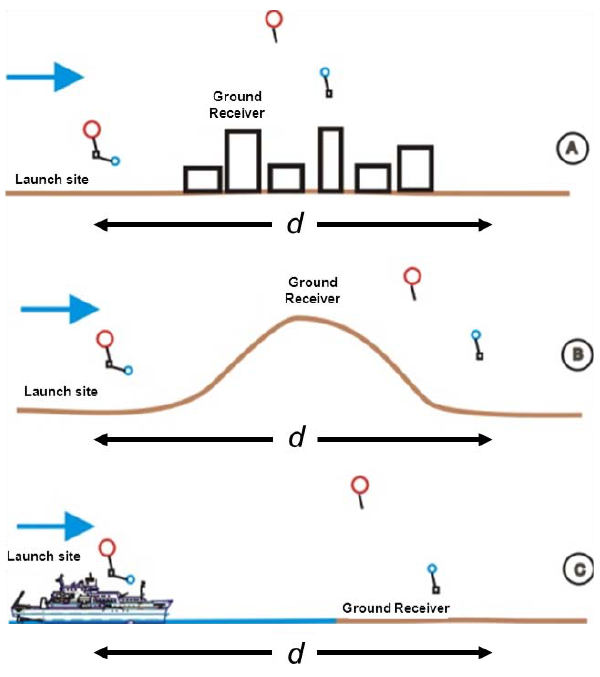
Fig. 4. Example of applications of the dual-balloon sounding sys- tem: (a) modification of boundary layer properties by a surface tran- sition, (b) measurement on each side of a mountain and (c) observa- tion of coastal breezes. Distance d indicates the distance that must be travelled by the radiosonde in order to achieve the objective. In (a) – (b) , the receiver is not operated at the launch site in order to have a good radio reception on each side of the town or of the moun- tain. In (c) , the “ground” receiver can be operated either on the boat or at the ground.